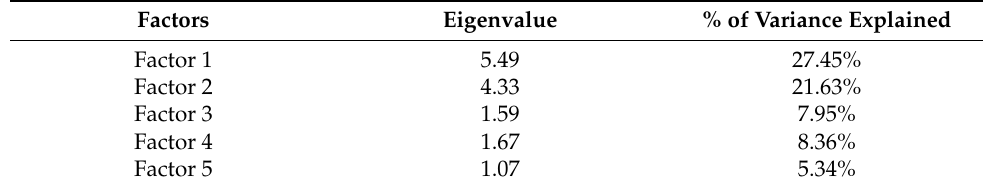
Table 3. Eigenvalues for the extracted factors.